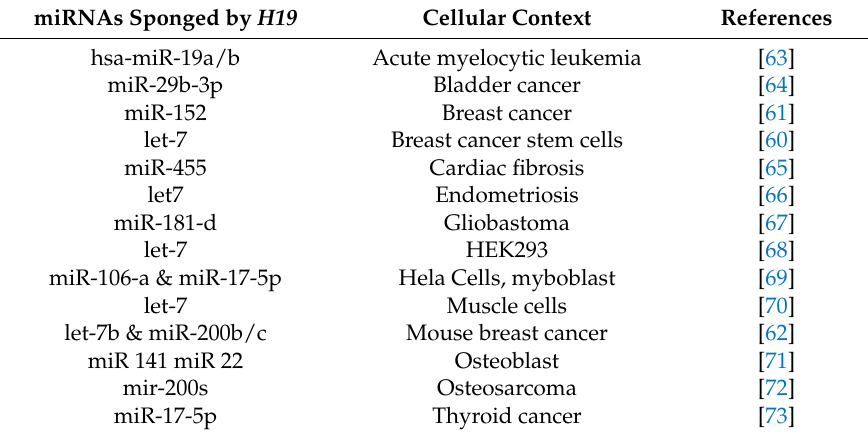
Table 2. Validated miRNAs sponged by H19 .